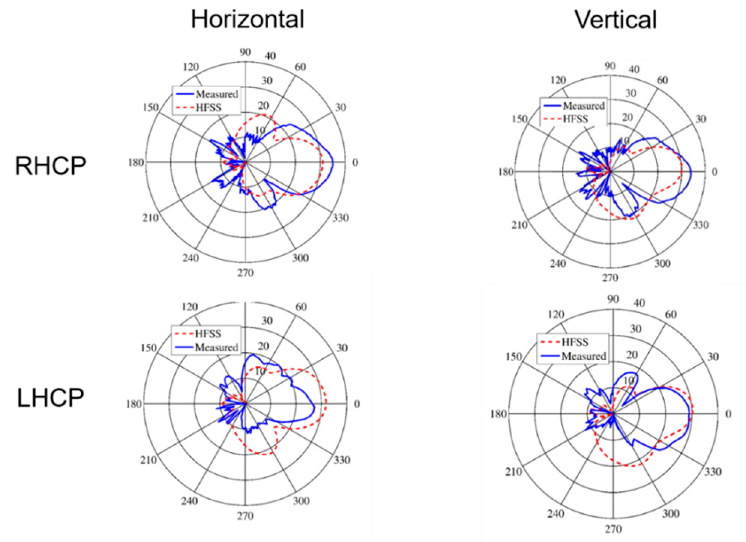
Figure 4. Antenna pattern, simulated through HFSS software [29] (dashed lines) and measured (solid line) for the vertical and horizontal plane.